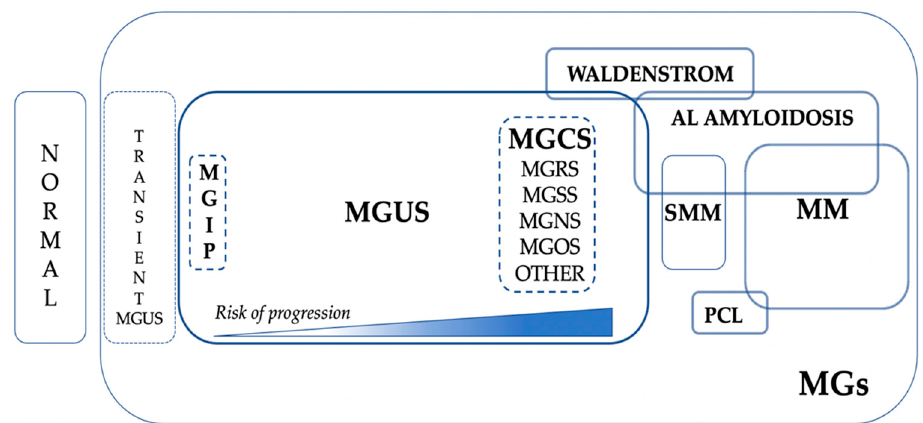
Figure 2. The global scenario of monoclonal gammopathies. Abbreviations: MGs; monoclonal gammopathies, MGCS; MG of clinical significance, MGIP; MG of indetermined potential, MGOS; MG of ocular significance, MGNS; MG of neurological significance, MGRS; MG of renal significance, MGSS; MG of skin significance, MGUS; MG of undetermined significance, MM; multiple myeloma, PCL; plasma cell leukemia, SMM; smoldering MM.